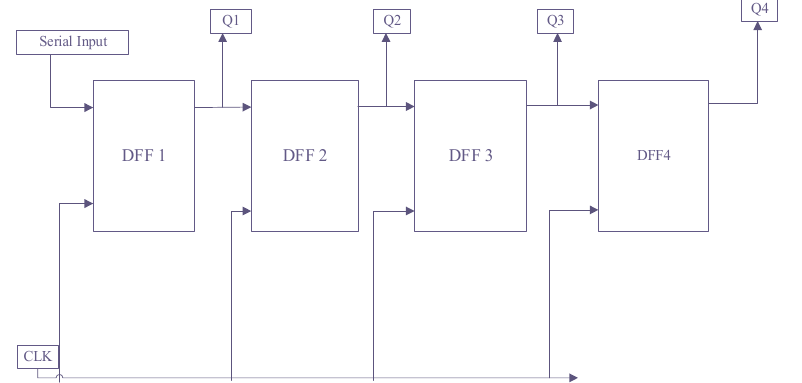
Figure 15. Block diagram representation of SIPO shift register.